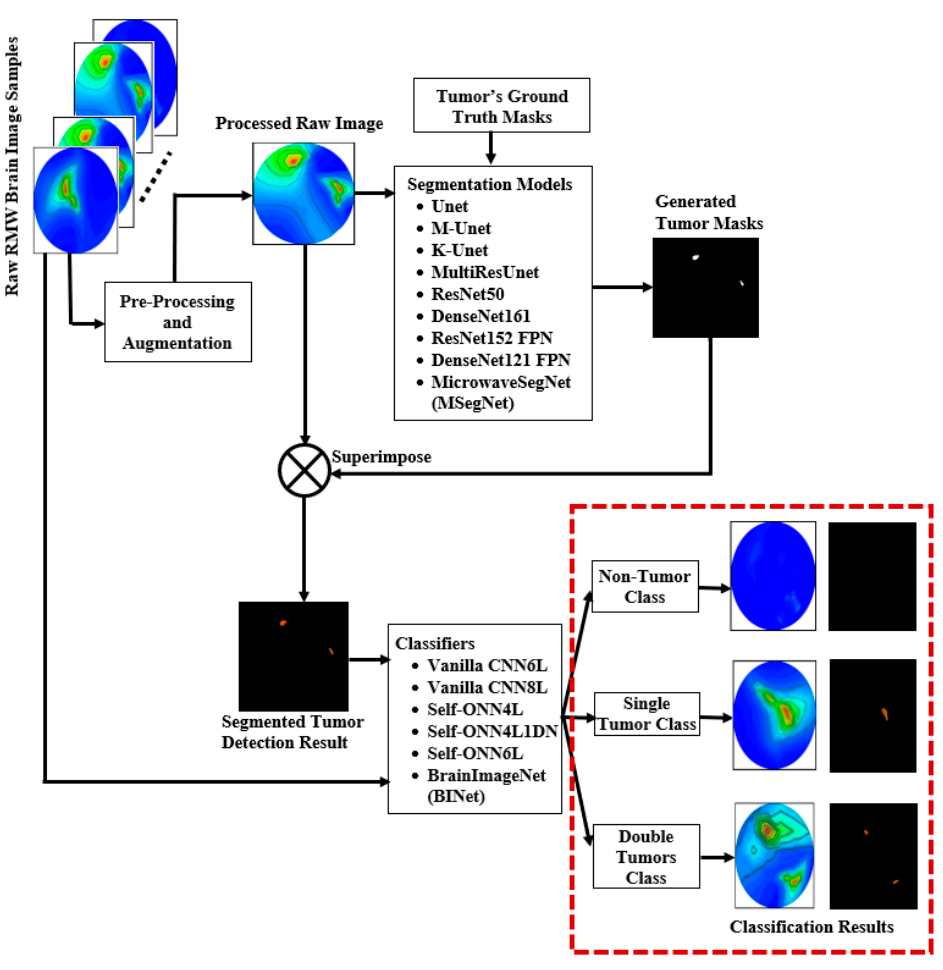
Figure 8. The complete methodology flow chart of the research work.